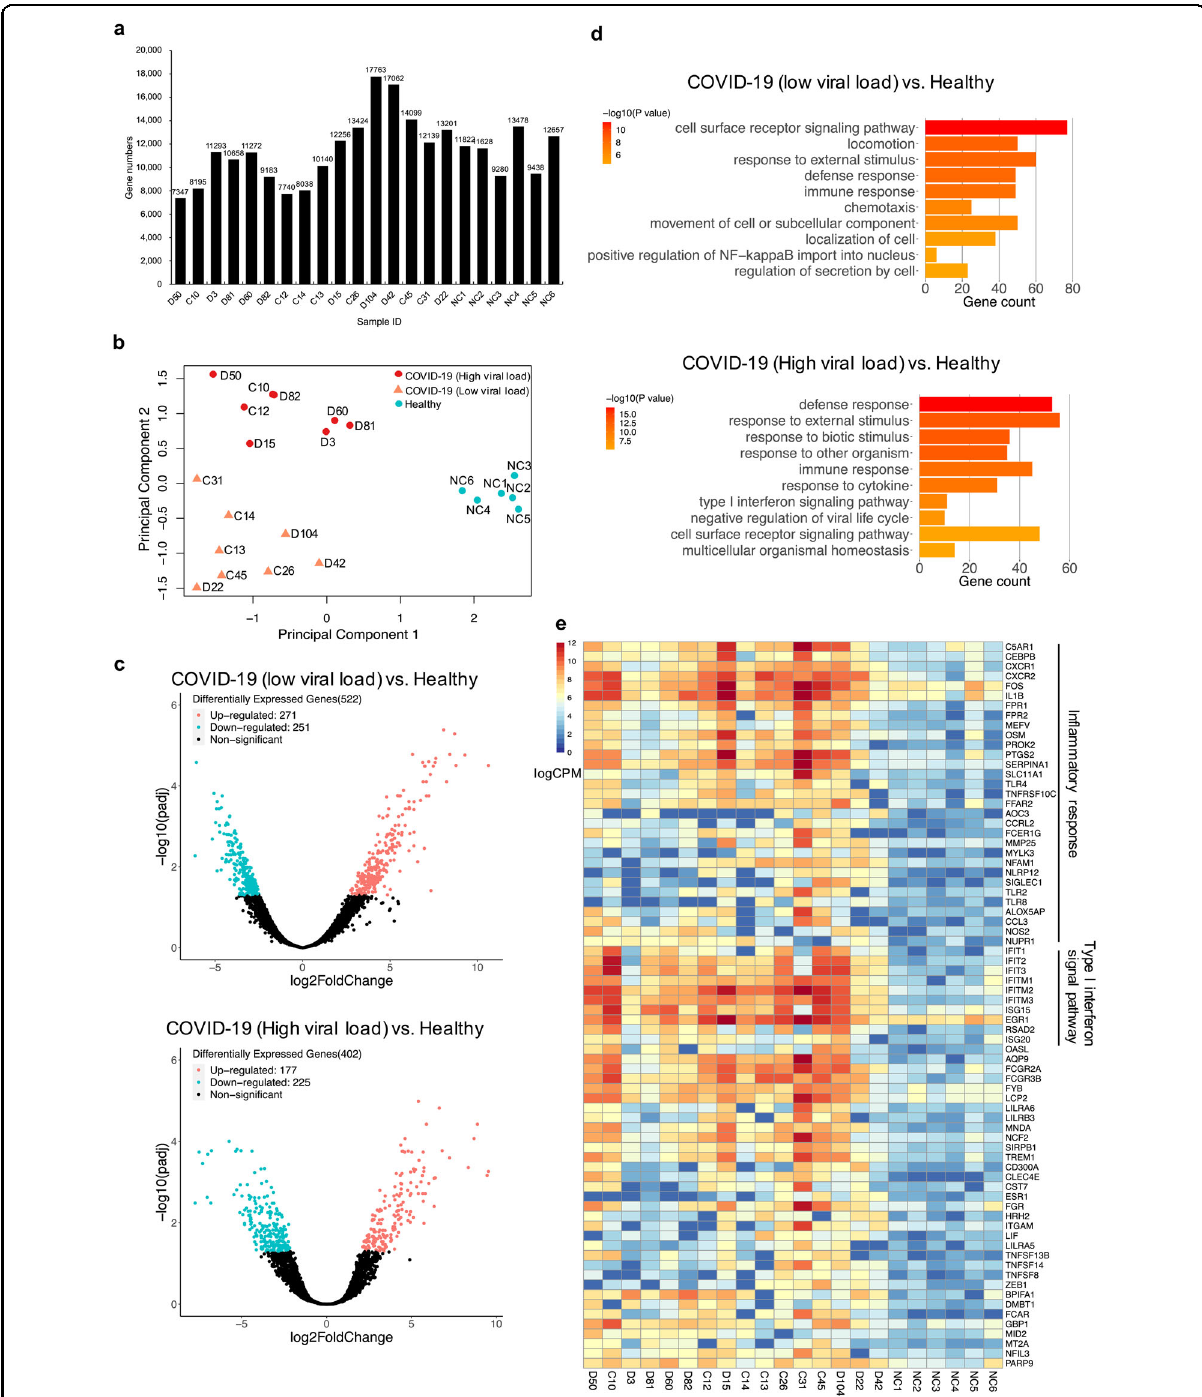
Fig. 4 Pro fi ling of host transcriptional response. a Bar plot showing gene numbers detected in each sample. b MDS plot showing variation among samples based on host transcriptional pro fi les. c Volcano plots showing differentially expressed genes between low SARS-CoV-2 viral load and negative samples (upper), and between high SARS-CoV-2 viral load and negative samples (lower), respectively. Signi fi cantly up- and down- regulated genes (padj < 0.05, |log 2 FoldChange| > 1) are highlighted in red and blue, respectively. d Bar plots of the most enriched GO terms in low and high SARS-CoV-2 viral load samples, respectively. e Heatmap presenting the signi fi cantly up-regulated immune response-related genes in SARS- CoV-2-positive samples compared to negative